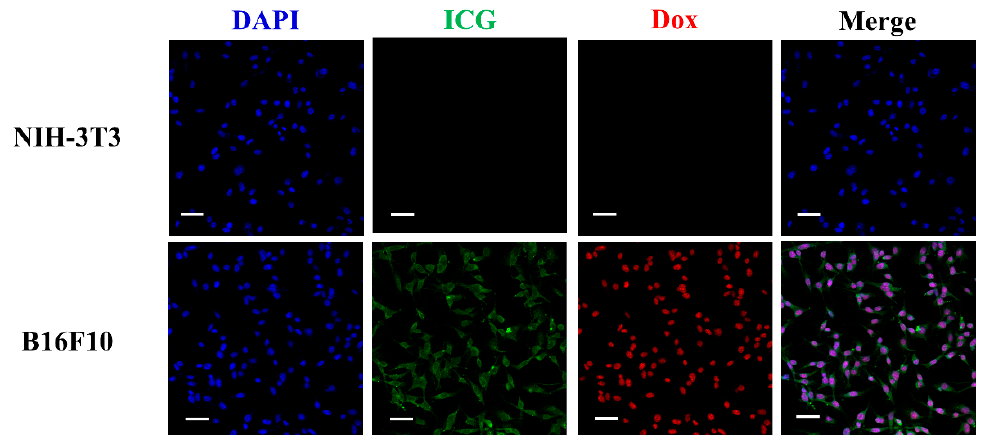
Figure 5. Cellular uptake behaviors of the NIH-3T3 and B16F10 cells incubated with the ID@MOS- Fc-CDHA nanocomposites. Scale bars are 20 μ m. DAPI: blue, ICG: green, and Dox: red color.